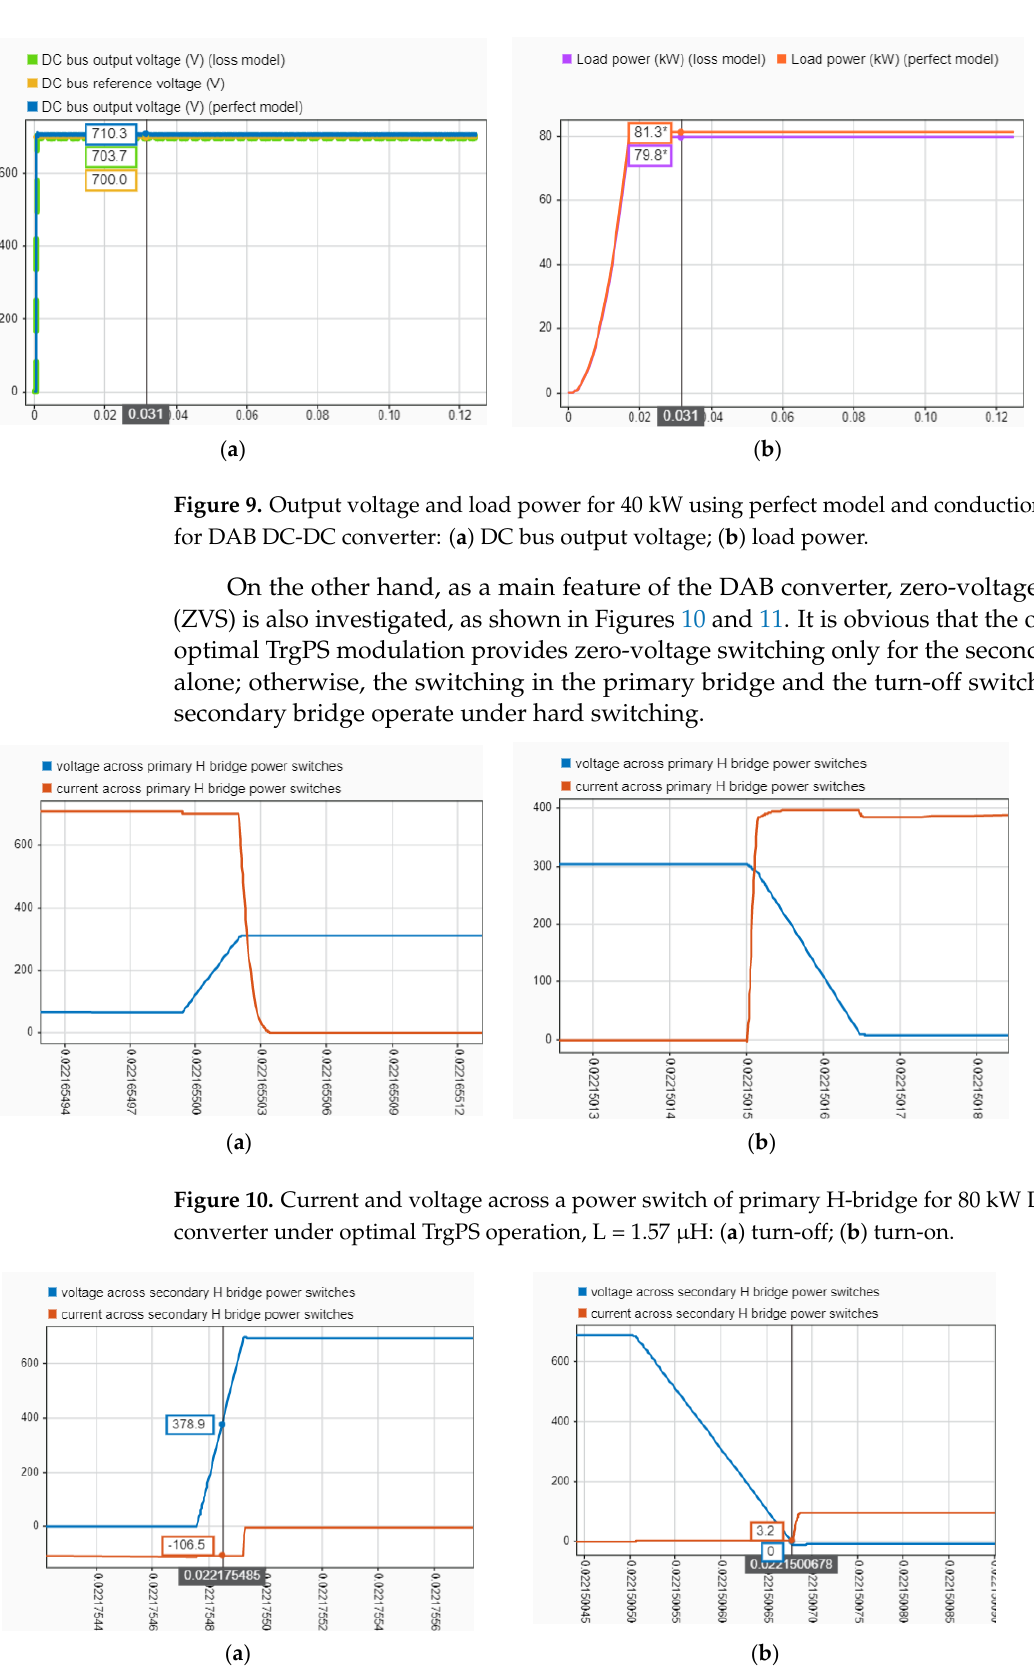
Figure 8. Load current and output voltage for the variation of the power load from 40 kW to 10 kW: